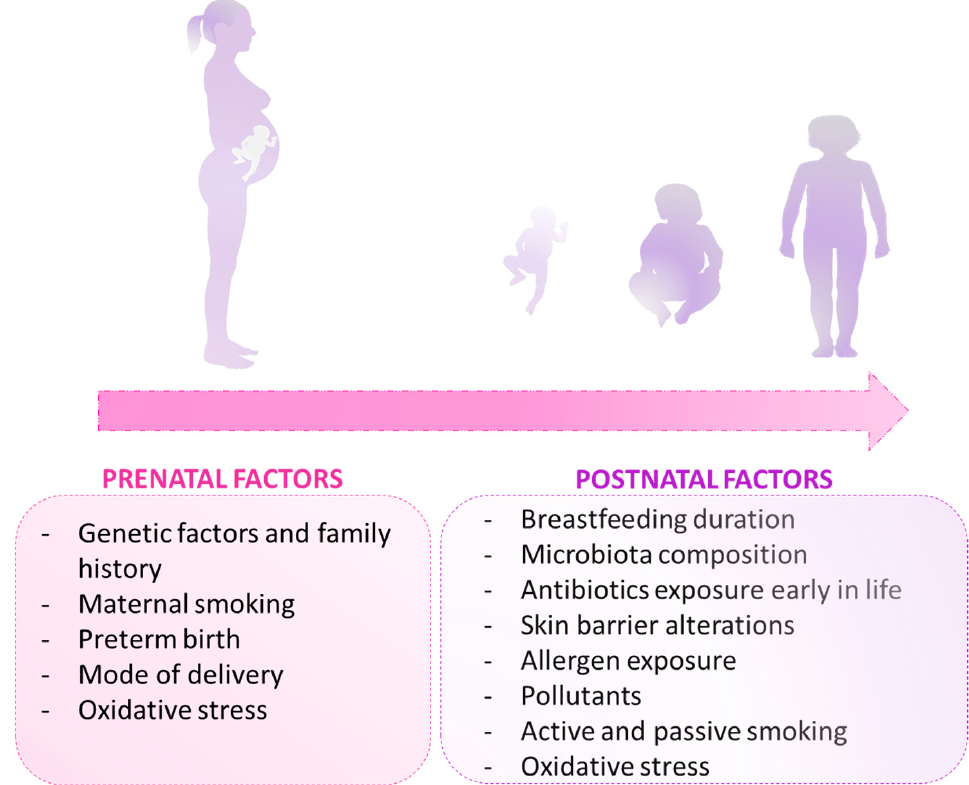
Figure 2. A non-exhaustive list of the main perinatal factors involved in the atopic march in different stages of life (pre- and post-birth). Genetic and environmental factors are implicated in the onset and progression of the atopic march. The environmental factors at the fetal stage (in utero), at birth, or after birth can affect the individual predisposition to allergic diseases. Some genetic backgrounds related to the cytokines and immune factors of interest in this review are discussed in Section 1.3.1.